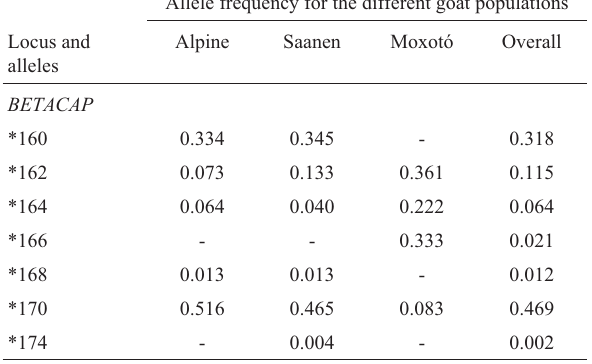
Table 1 - Locus , alleles (*kb) and allele frequencies (F) for the Alpine, Saanen and Moxotó breeds. The last column shows the overall allele frequency. Alleles undetected in a specific population are indicated by a dash (-) and PCR conditions are given as a footnote. Allele frequency for the different goat populations Locus and alleles